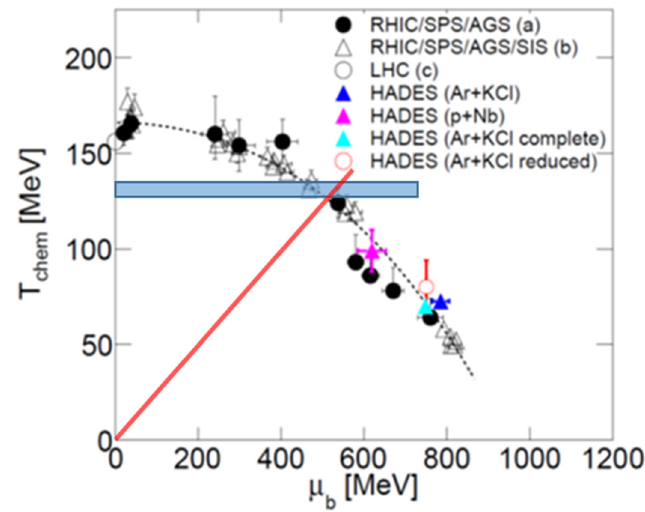
Figure 6. Chemical freeze-out temperatures T chem as a function of the baryon chemical potential μ b extracted from particle yields measured at different energies [24]. The black dashed line is calculated assuming a fixed energy per nucleon of 1 GeV [26]. Blue-shaded area: upper limit for the chiral critical point T 0c = 132 + 3 − 6 MeV [21,22]. According to FRG calculations, the location of the chiral critical endpoint is excluded for values smaller than μ b /T = 4 (below the red line) [27].